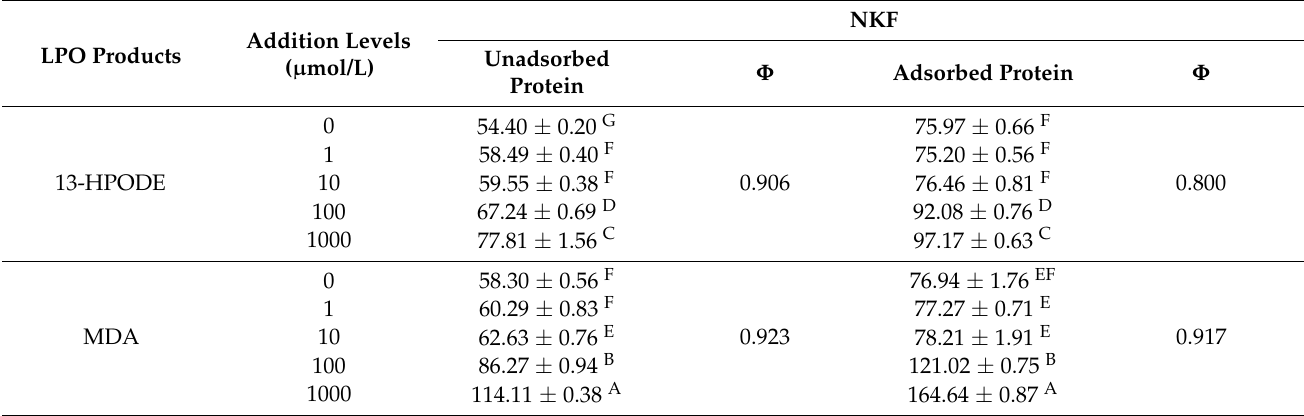
Table 5. NKF of unadsorbed and adsorbed proteins extracted from the O/W emulsion oxidized by different levels of 13-HPODE or MDA for 24 h.